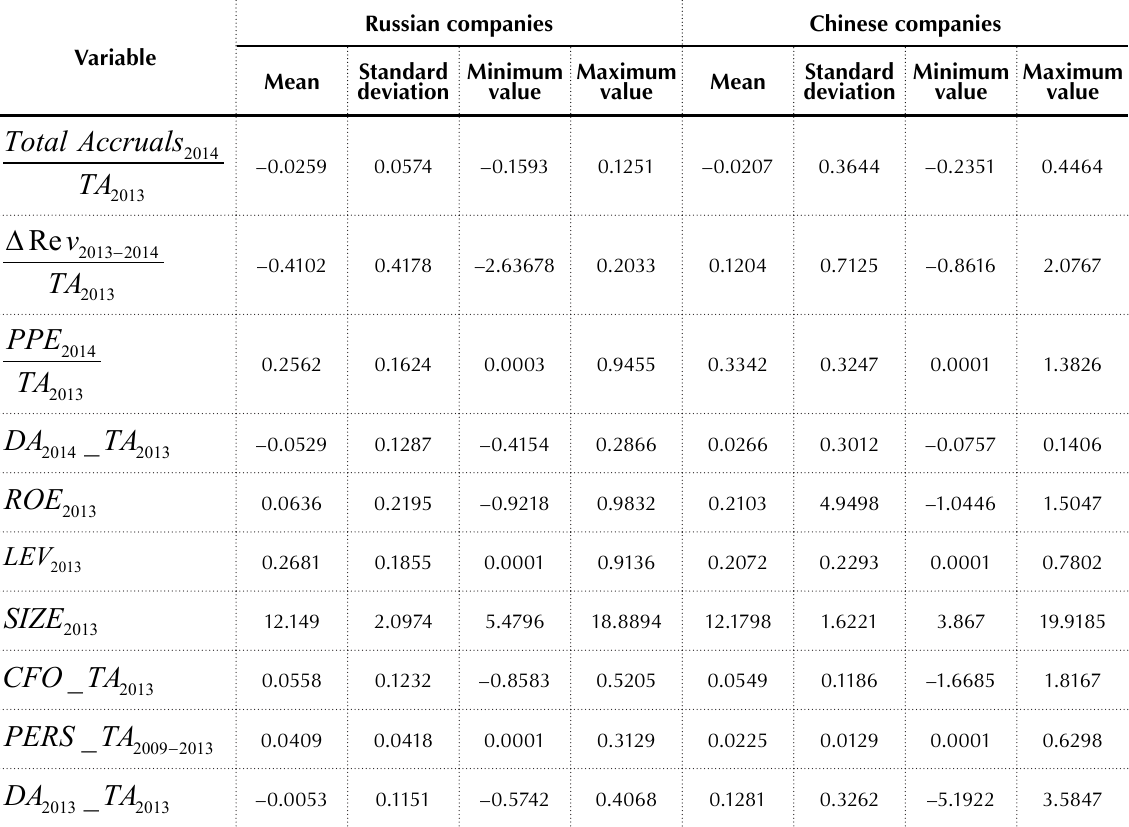
Table 2. Descriptive statistics of Russian and Chinese samples of data